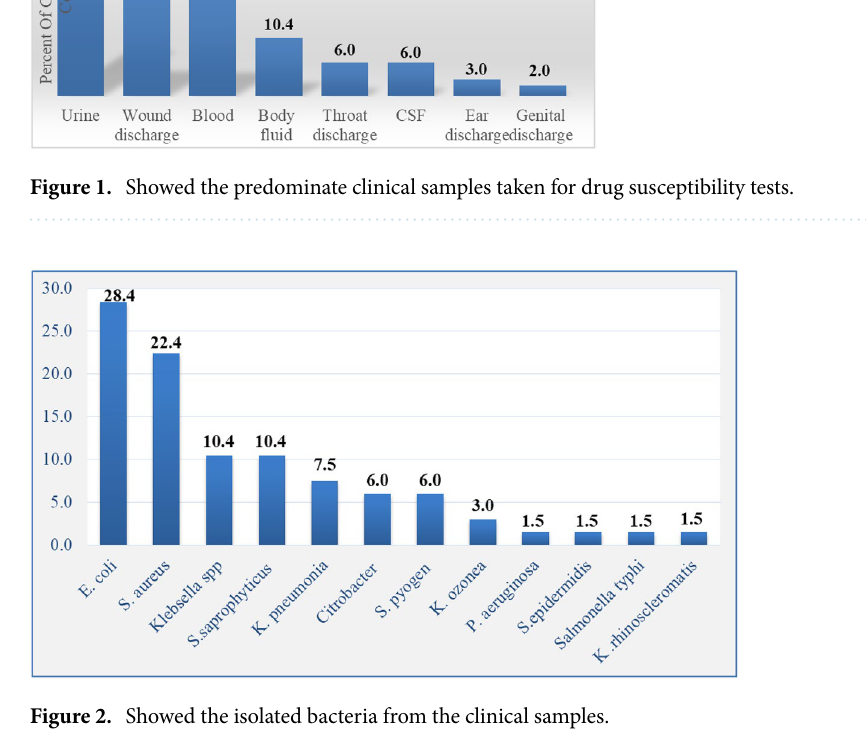
Figure 2. Showed the isolated bacteria from the clinical samples.